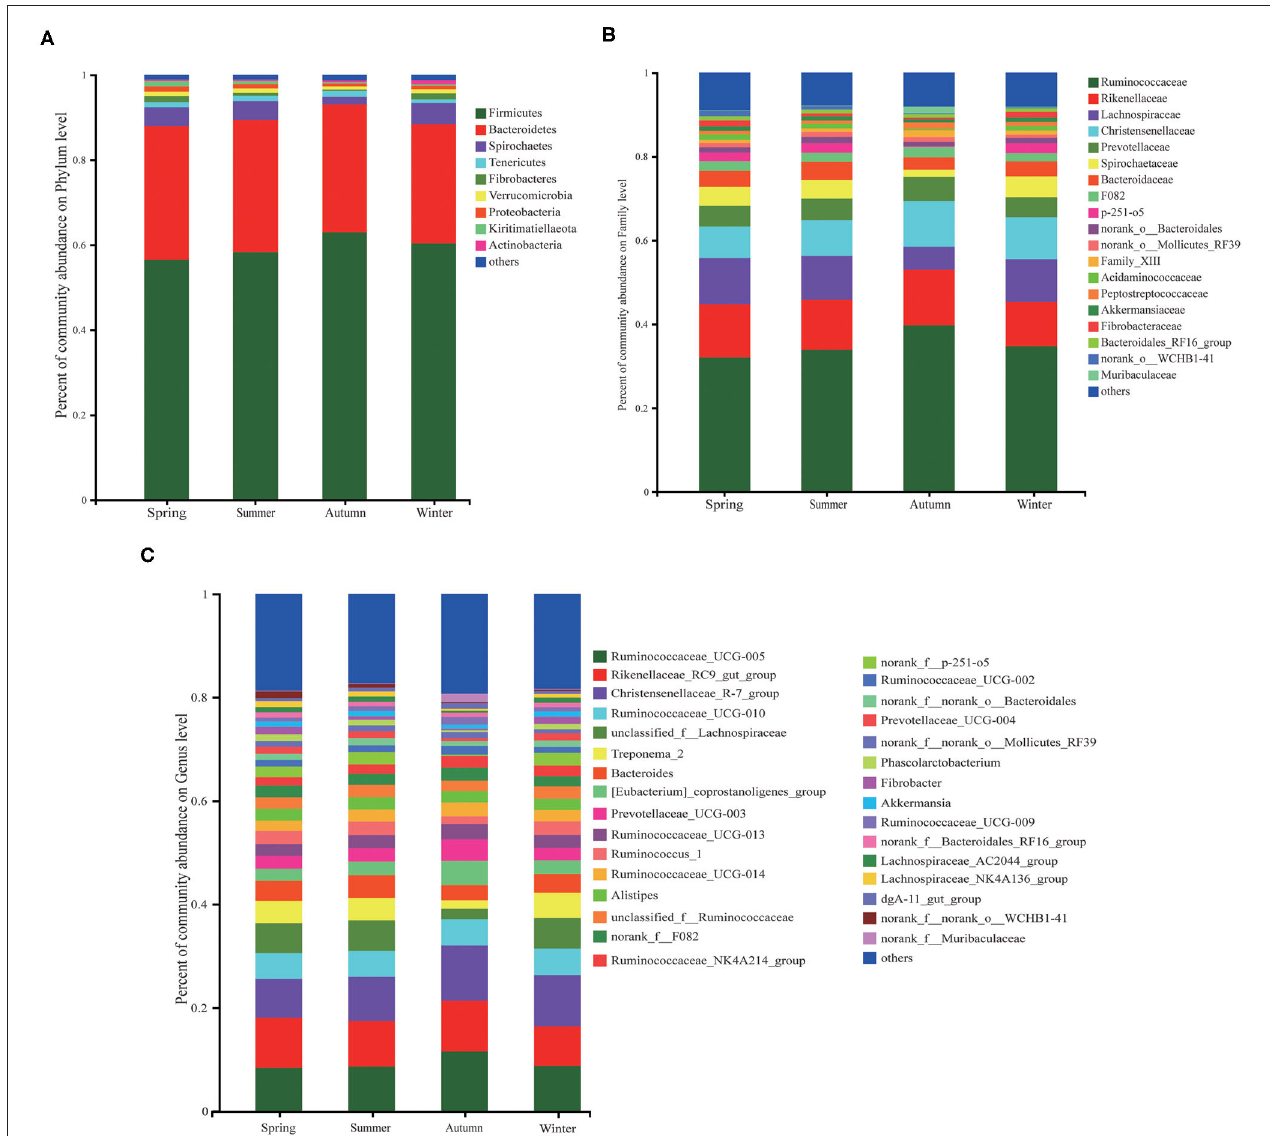
FIGURE 4 | The relative abundance of microorganisms at the level of phyla, family and genus in different seasons (the abundance below 1% were merged with others). (A) The phyla level of fecal bacterial communities. (B) Fecal bacterial community at the family levels. (C) Fecal microbiota at the genus levels.